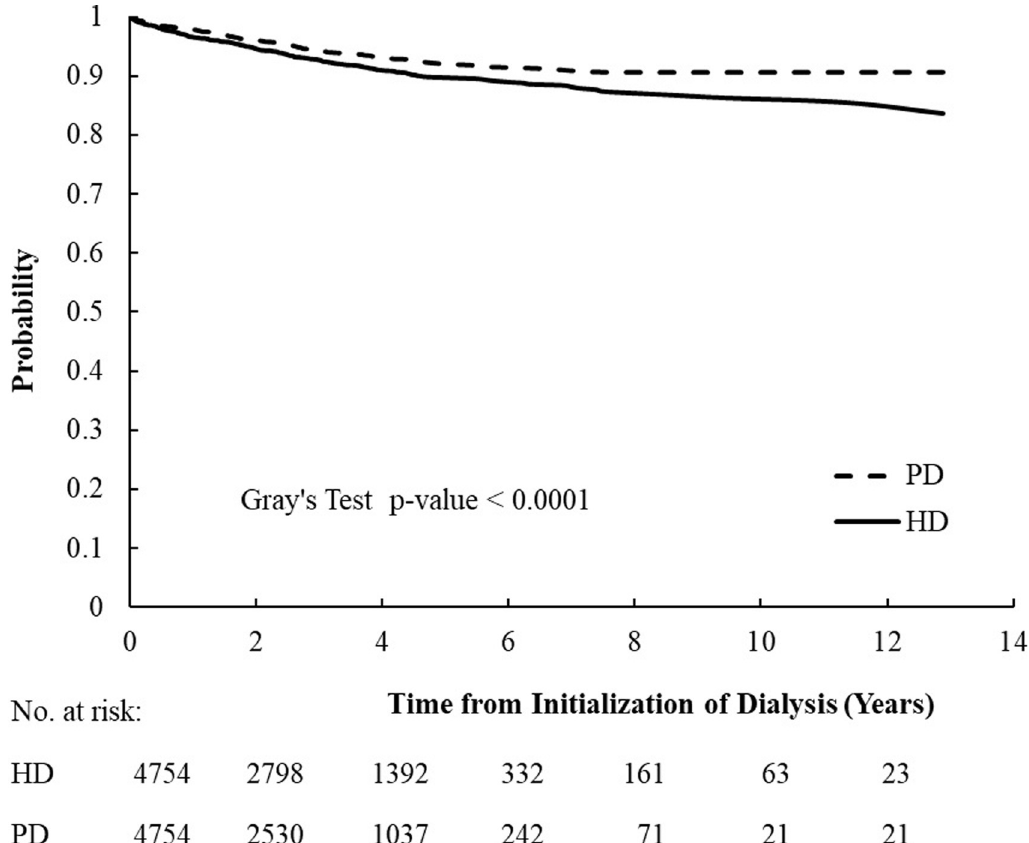
Fig 2. Comparison of cumulative congestive heart failure free survival rates between matched pairs of hemodialysis (HD) and peritoneal dialysis (PD) patients after accounting for competing risk of mortality.